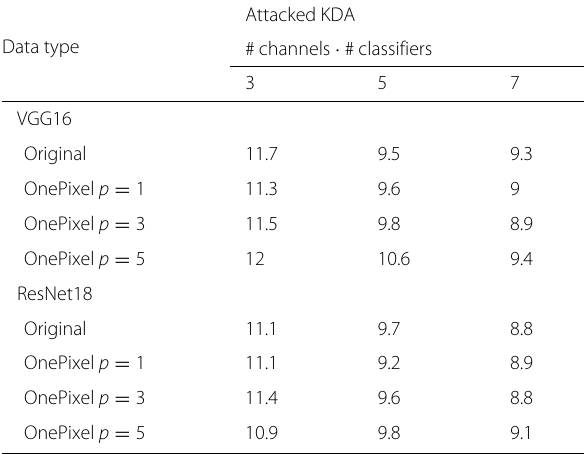
Table 6 Classification error (%) on the first 1000 test samples (CIFAR-10) for the multi-channel system against the direct black-box OnePixel attacks with randomly selected channels (the average results over 10 runs) Data